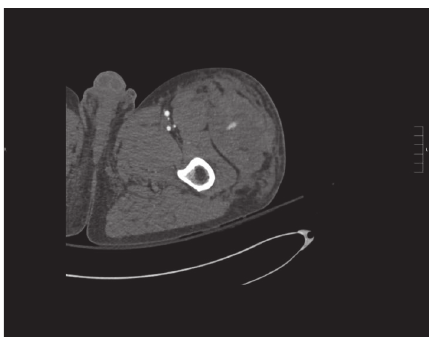
Figure 1: Contrasted enhanced CT of the left thigh demonstrates an area of extravasation and surrounding hematoma.